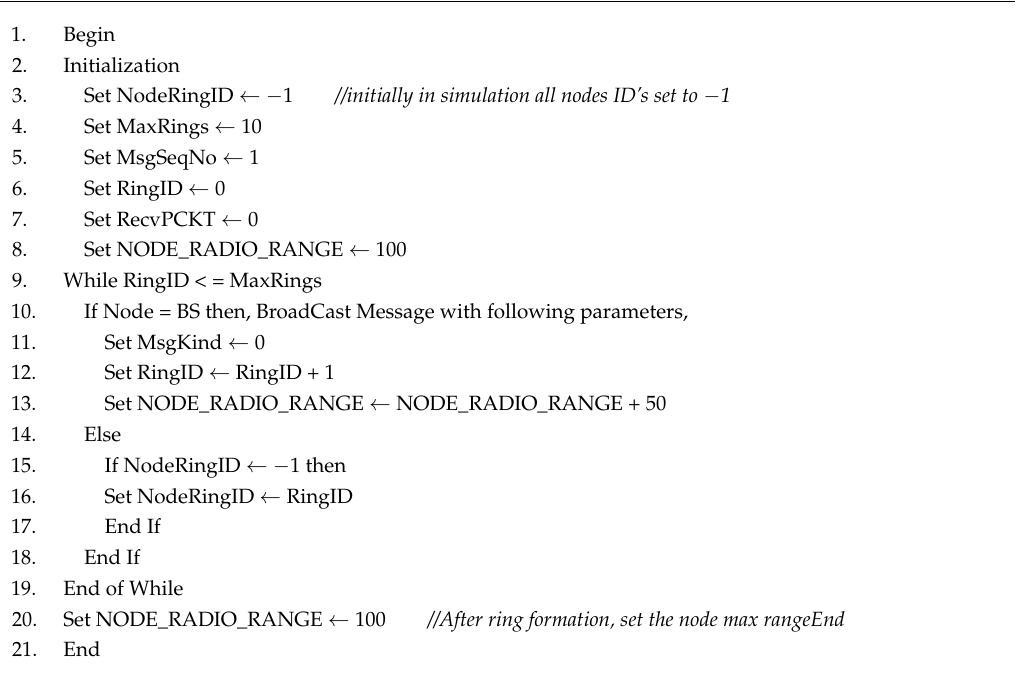
Algorithm 1: Pseudo code for Network Configuration/setup phase